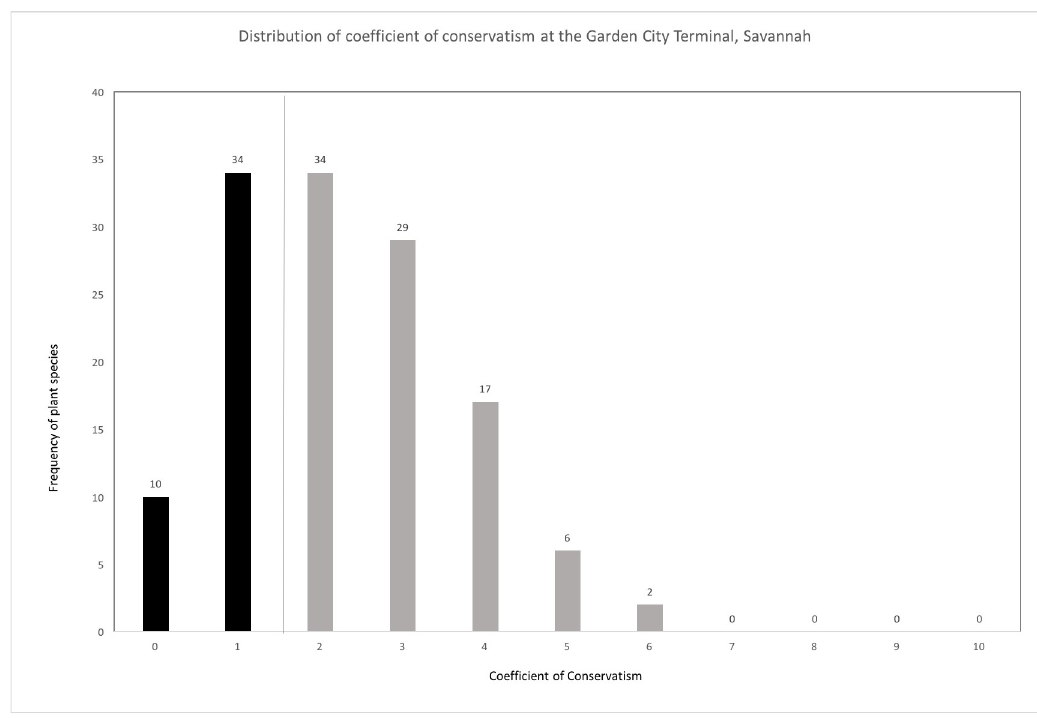
Fig 7. Distribution of the coefficients of conservatism of the species collected at the Garden City Terminal, Port of Savannah, Georgia, USA. Coefficients with a value of 0 or 1 represent nonnative species and those with a value of 2 or higher represent native species. Of the 174 species found at GCT, 42 did not have Coefficient of Conservatism values provided [36].